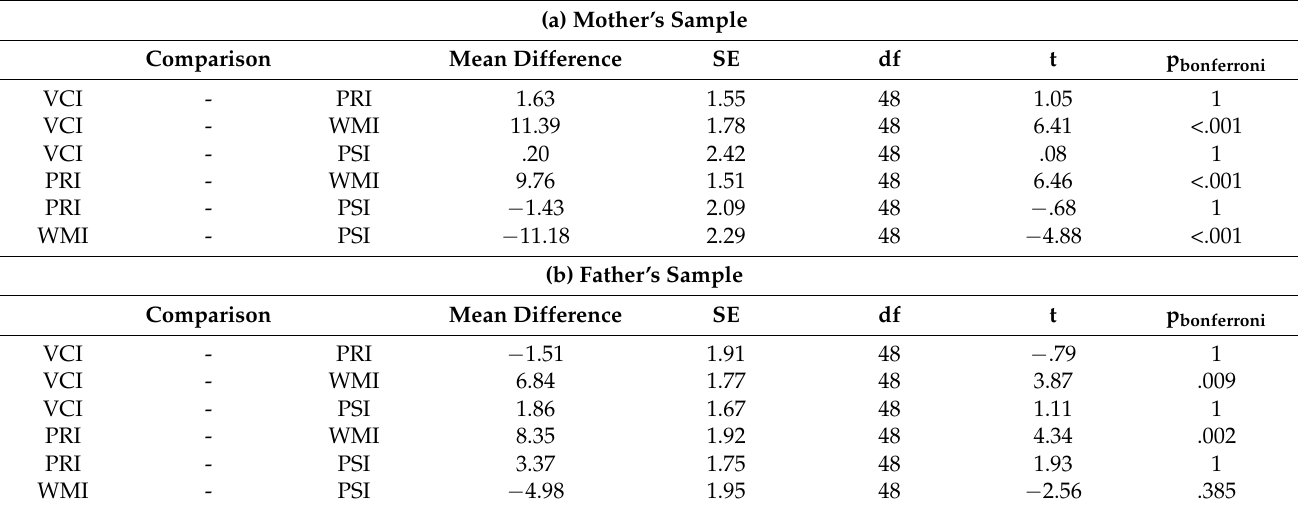
Table 6. Bonferroni-corrected post-hoc tests comparing the WISC-IV primary indices.